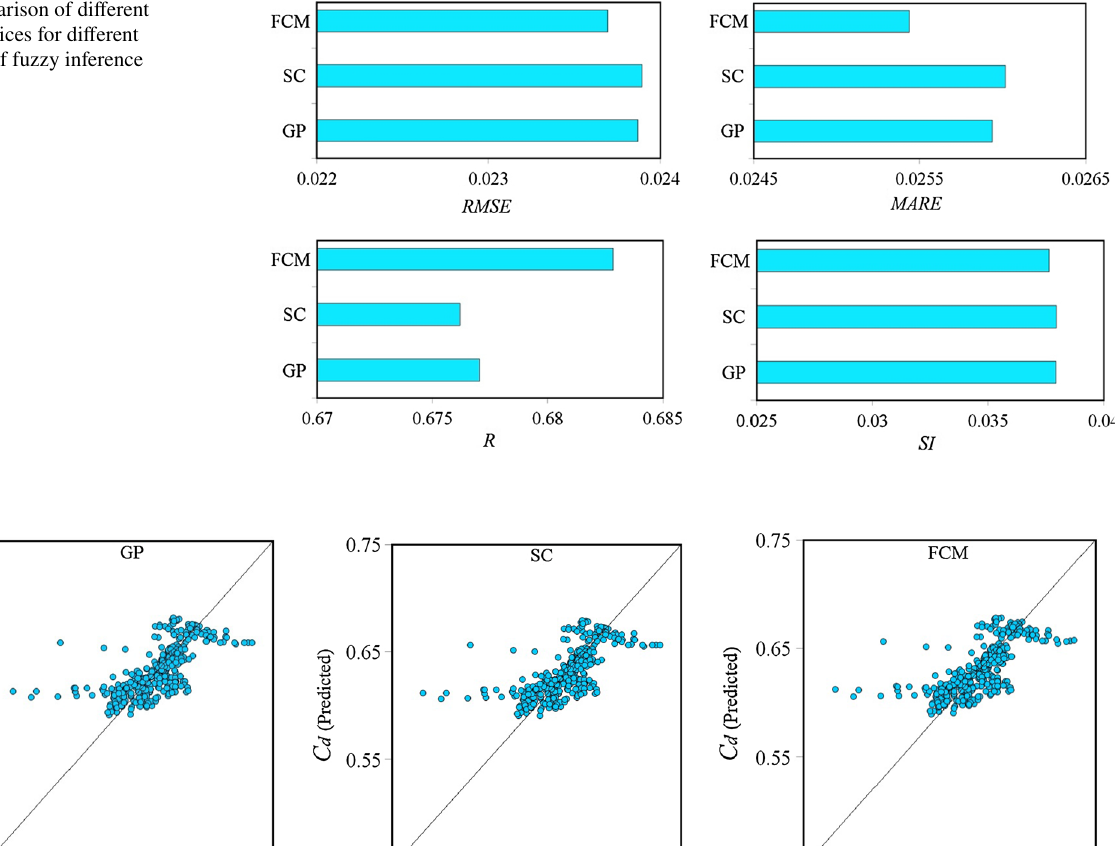
Fig. 6 Comparison of different